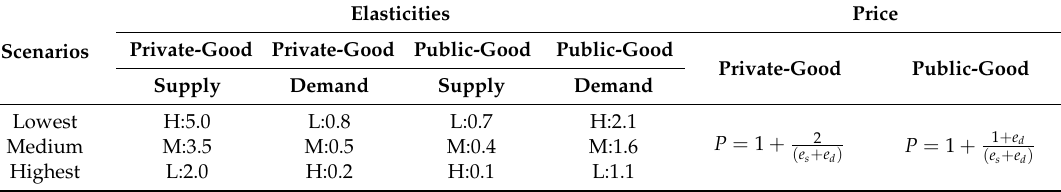
Table 1. Price elasticities of supply and demand for private-good and public-good ecosystem services resulting in relative changes in scarcity value in the three scenarios analyzed in this study, and relative